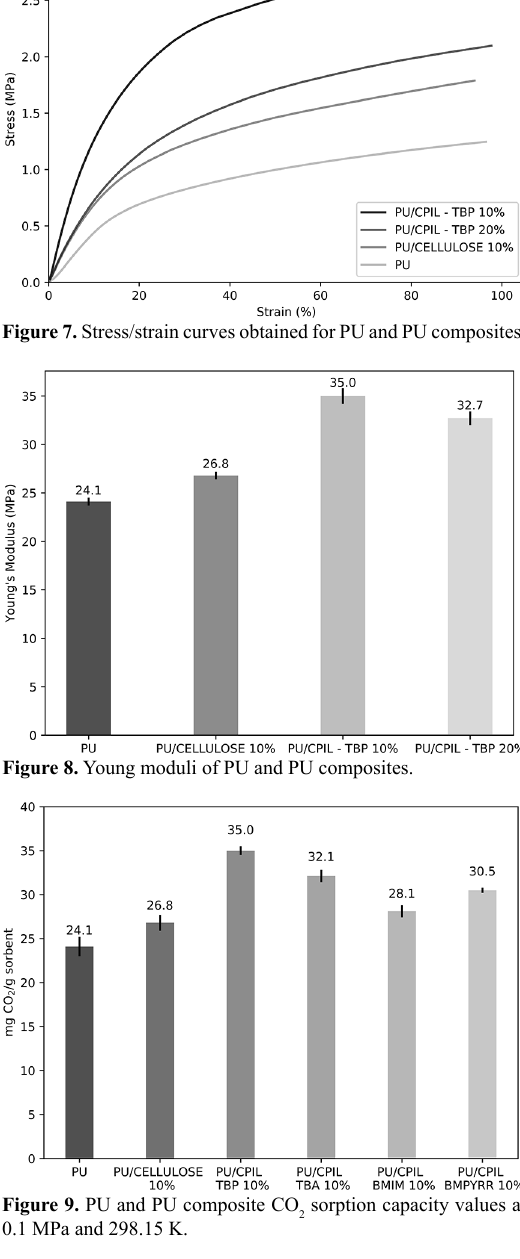
Figure 9. PU and PU composite CO 0.1 MPa and 298.15 K. Table 1. Comparison of PU/CPIL - TBP -10% CO Sorbent